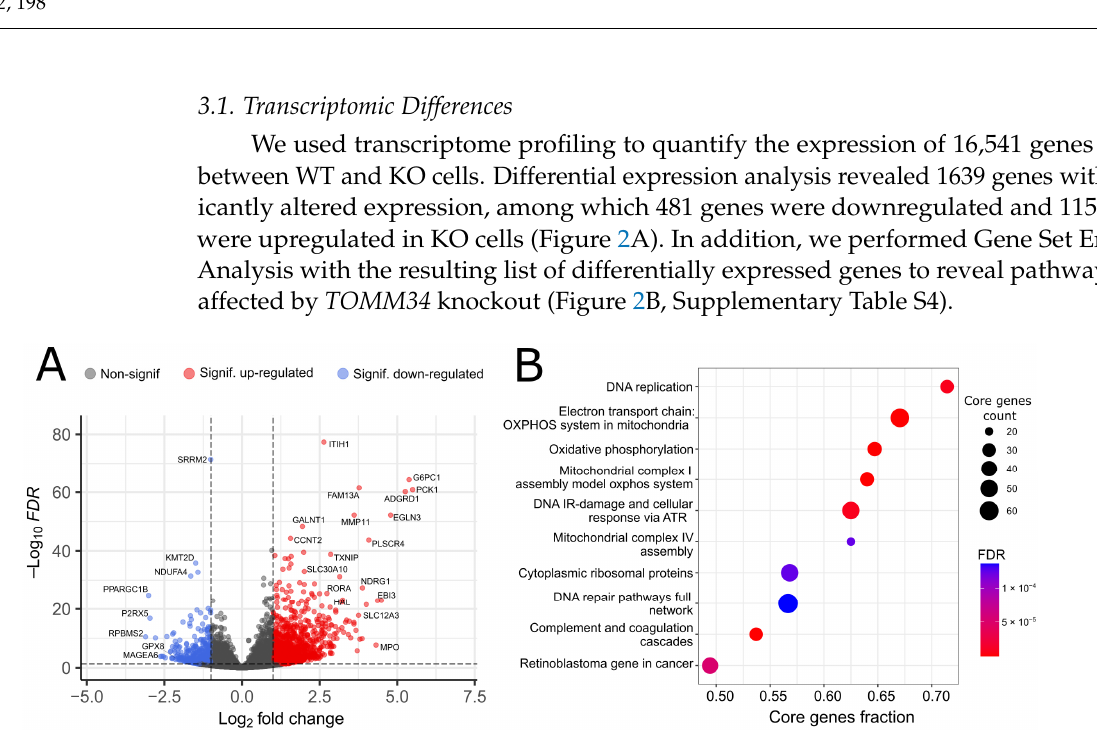
Figure 1. The overall workflow of the experiment to investigate the functional capacity of TOMM34 .